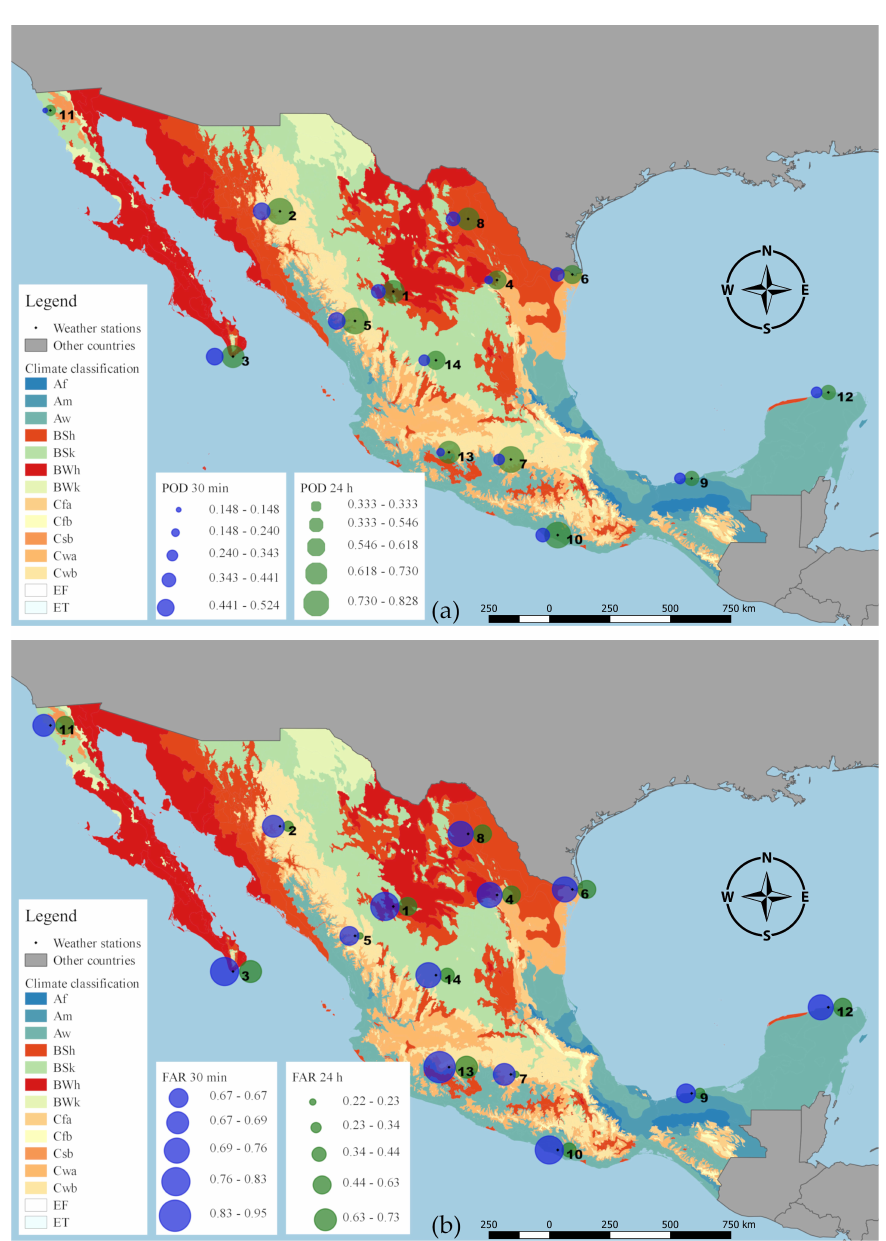
Figure 8. Spatial distribution of ( a ) POD and ( b ) FAR of the SBP CMORPH-CTR product on the study sites, for the two analyzed levels of temporal